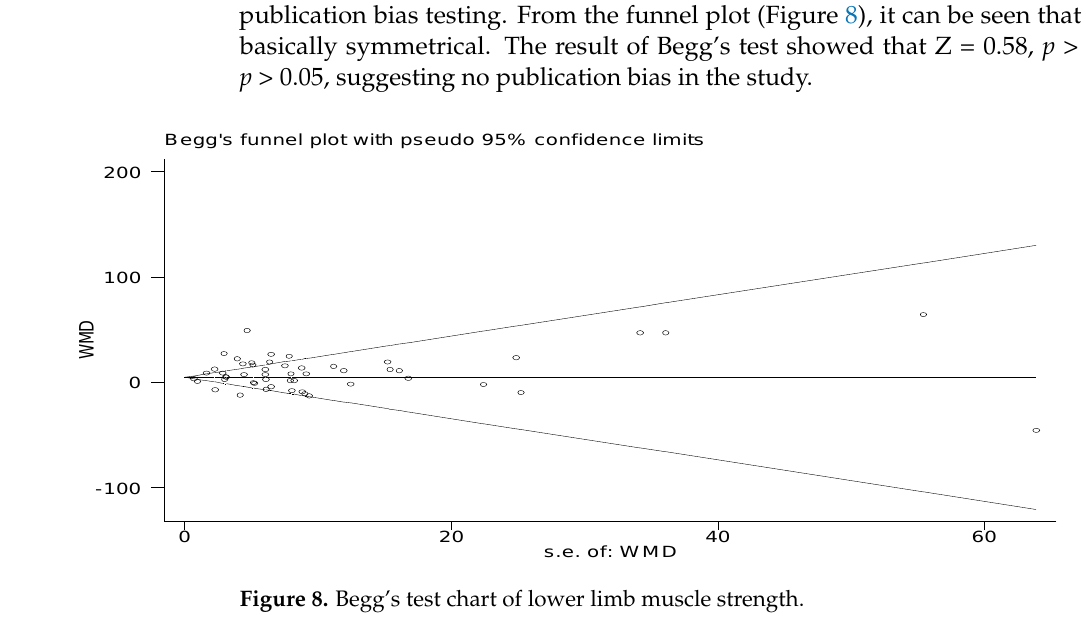
Figure 8. Begg’s test chart of lower limb muscle strength.